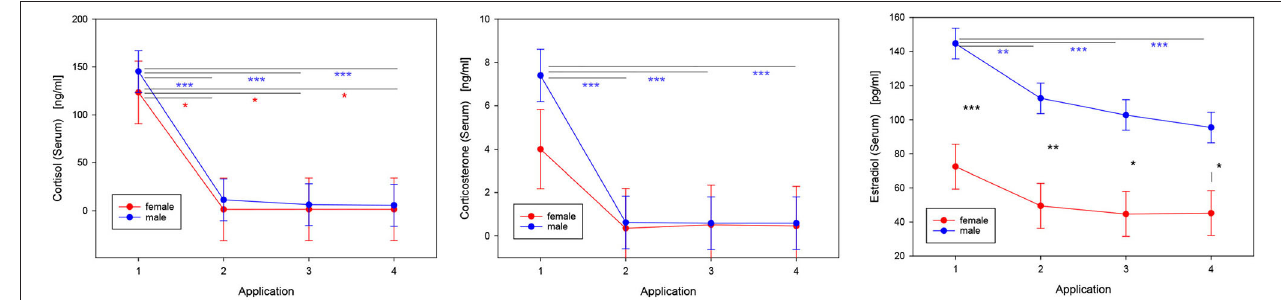
FIGURE 3 | Effects of repeated intrathecal TCA administration on concentrations of steroid hormones in serum. LS-means and SE are shown for those steroids that were significantly modulated in response to the therapy ( Table 2 ). The injections of TCA were performed in treatment cycles consisting of 4 consecutive applications with 2-day intervals (pairwise multiple comparisons with the Tukey-Kramer procedure: * p < 0.05; ** p < 0.01; *** p < 0.001; n cycles = 20: 6 cycles of 2 females, 14 cycles of 4